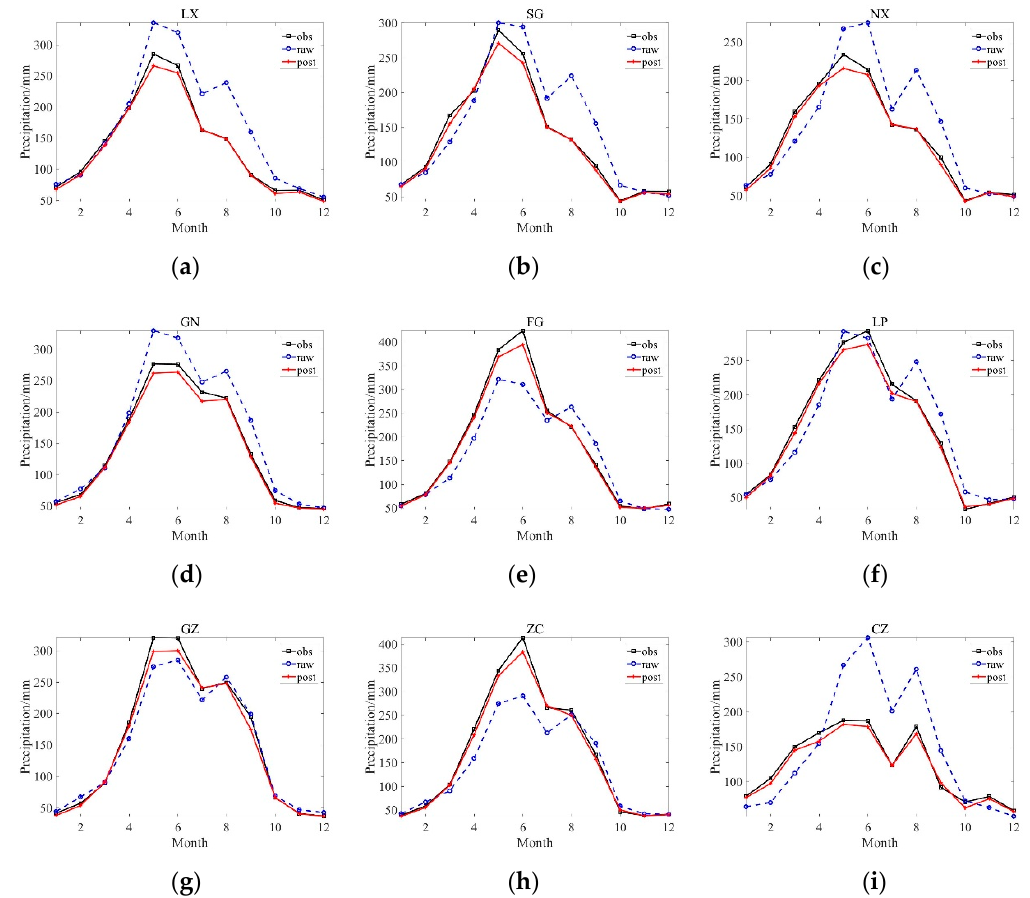
Figure 13. Comparison of annual average monthly precipitation before and after post-processing of GEFS with observed data: ( a ) Lianxian; ( b ) Shaoguan; ( c) Nanxiong; ( d ) Guangning; ( e ) Fogang; ( f ) Lianping; ( g ) Guangzhou; ( h ) Zengcheng; and ( i ) Chenzhou.